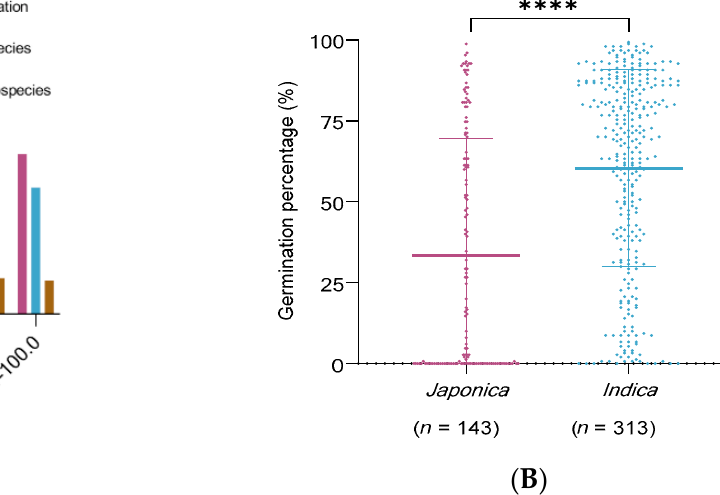
Figure 2. The difference phenotype of 456 rice accessions. ( A ) Distribution and variations of seed germination percentage at temperature 42°C and relative humidity 88% for 20 days in the whole population, indica subspecies, and japonica subspecies. ( B ) Scatter dot plot of seed germination percentage in indica subspecies and japonica subspecies. **** denote significant differences in mean phenotypic between superior and inferior alleles at p >